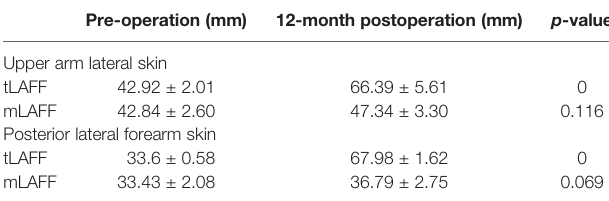
TABLE 3 | Two-point discrimination distance in the donor site.